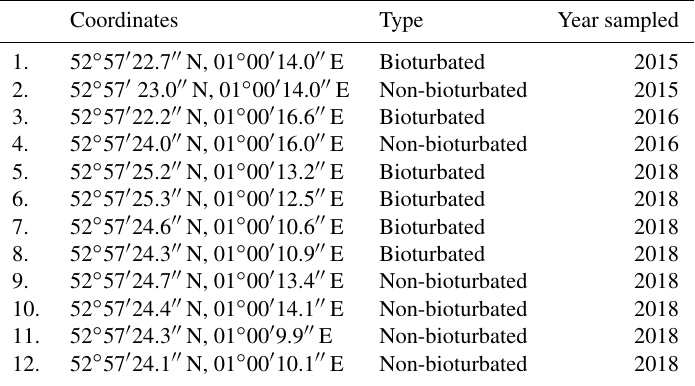
Table A1. Coordinates and type of the ponds sampled in the 2015, 2016 and 2018 field campaigns in the Blakeney salt marsh. See Fig. 1c in the main text for relative geographical location of the ponds.